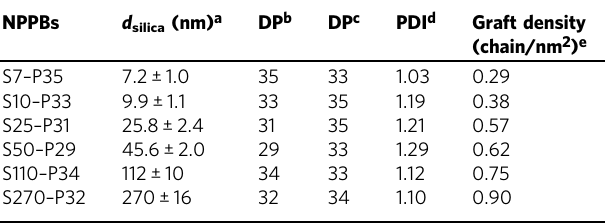
Table 1 The structural characteristics of model